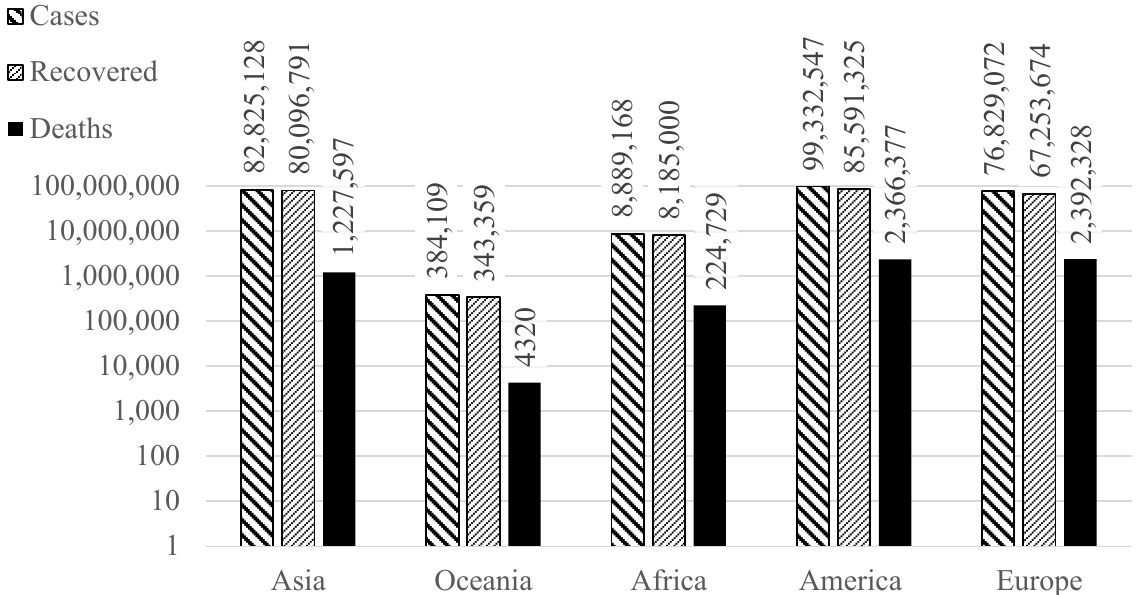
Figure 1. Stats of COVID-19 worldwide until the ninth of December 2021.